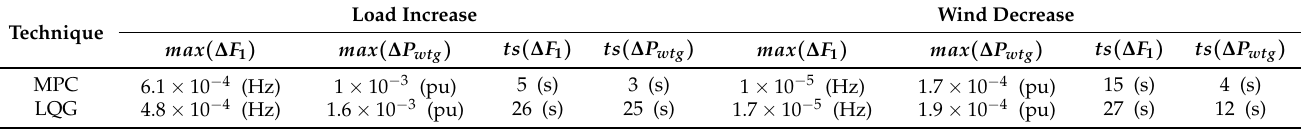
Table 3. Performance comparison between the decentralized MPC and LQG control schemes in terms of over/undershoot ( max ( . ) ) and settling time ( t s ( . ) ) of the frequency and active power deviations. Load Increase Wind Technique